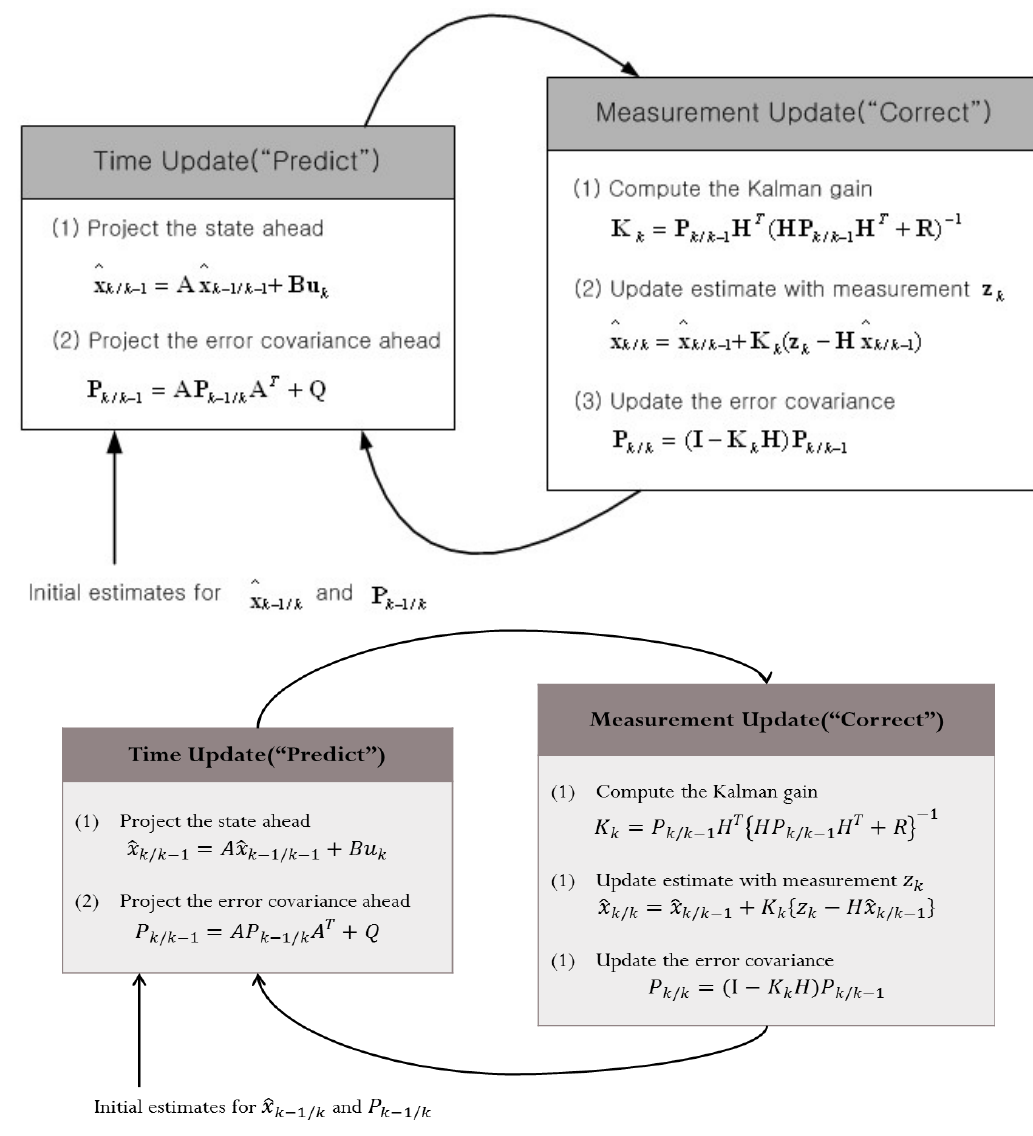
Figure 3. The operation of the Kalman